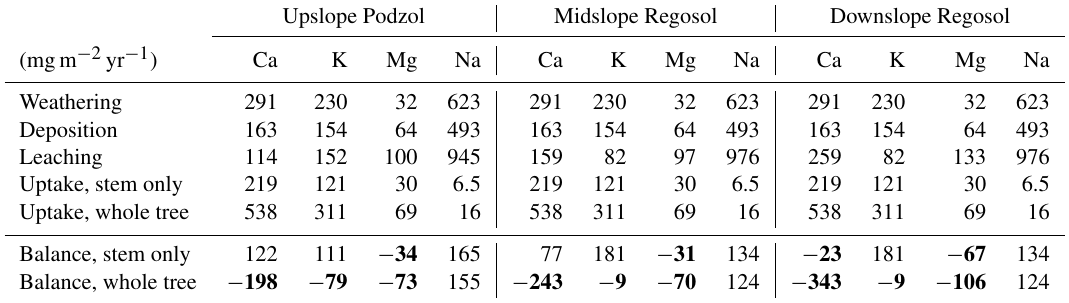
Table 2. Mass balances for the three soils collected along the hydrological gradient at Kindla based on annual fluxes of Ca, Mg, K, and Na (mgm − 2 yr − 1